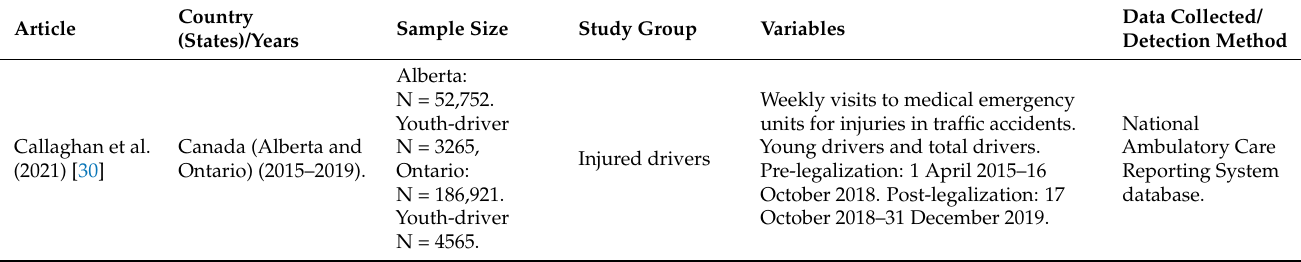
Table 3. Studies related to the legalization of recreational cannabis: country, sample, and most relevant